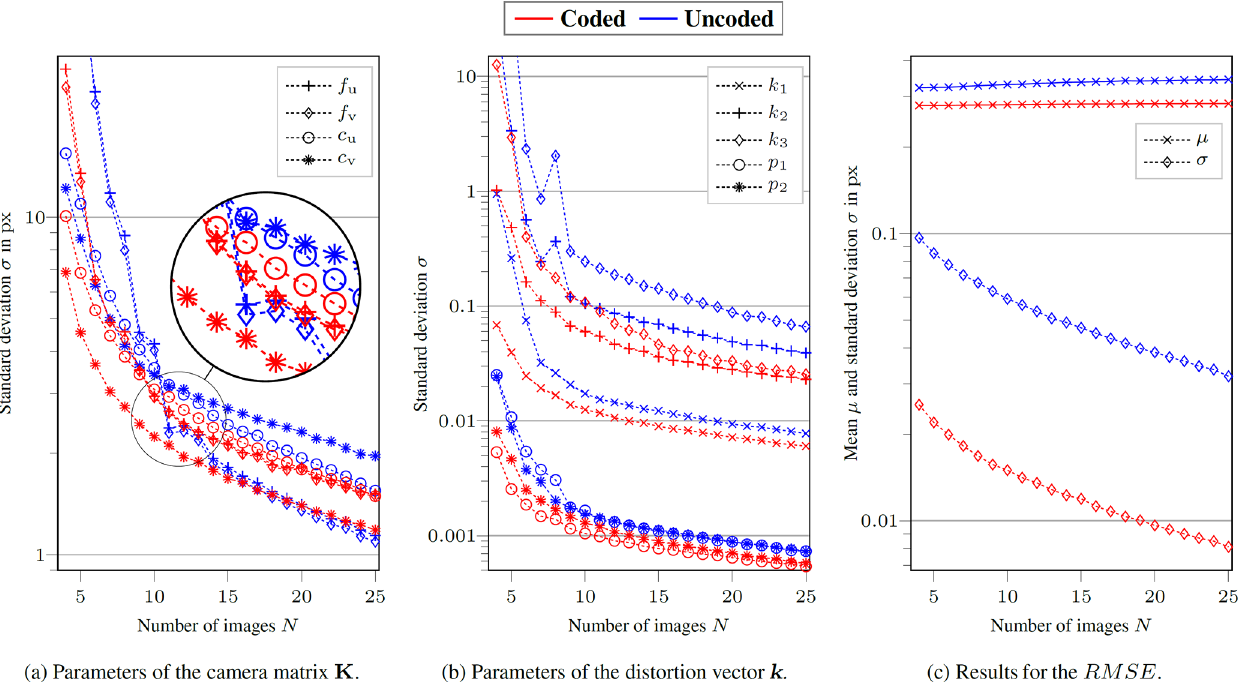
Figure 8. Logarithmic plots of the individual calibration parameter standard deviations σ (a, b) and the resulting RMSE standard deviation σ and mean value µ (c) as functions of the number N of images per subset for M = 10000 calibration runs and RMSE filtering at the 90th percentile. To improve visualization of the trends in the data shown, high values for the uncoded target at small N (e.g. σ ( f v ,N = 4) = 143 . 3, σ ( k 3 ,N = 4) = 1071) were truncated. Table 2. Results of the intrinsic camera calibrations with N = 20, M = 1000 and no percentile filtering. CH: values from the data set sep 20 in Choinowski et al. (2019); not comp.: mean value µ is not comparable due to manufacturing tolerances and potentially different focus settings. The best values for each parameter are shown in